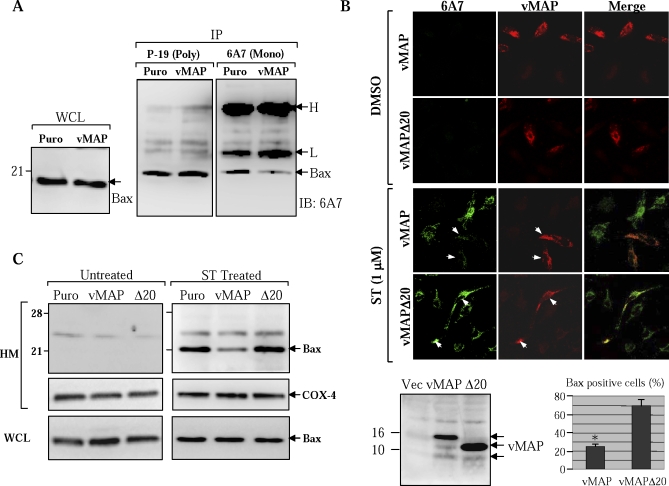
vMAP Inhibits the Mitochondrial Translocation and Activation of Bax(A) vMAP inhibits the apoptotic conformational change of Bax. NIH3T3/puro (Puro) and NIH3T3/vMAP (vMAP) cells were treated with ST (1 μM) for 4 h, harvested, and lysed in 1% CHAPS buffer. Pre-cleared cell lysates were split into two fractions, and each was used for immunoprecipitation with the mouse 6A7 monoclonal antibody or the rabbit P-19 polyclonal antibody, followed by immunoblotting with 6A7. WCLs were analyzed by immunoblotting with 6A7 antibody. Of note, 6A7 antibody reacts only with the activated Bax in immunoprecipitation and immunofluorescence assays, but with pan-bax in the immunoblotting assay. H and L indicate the heavy and light chains of immunoglobulin, respectively. WCL, whole cell lysate.(B) vMAP inhibits Bax activation by immunofluorescence assay. At 16 h post-transfection with a plasmid expressing vMAP or vMAPΔ20, HeLa cells were treated with DMSO or ST (1 μM) for 4 h, fixed, and stained with rabbit anti-vMAP serum (red) and the mouse 6A7 monoclonal anti-Bax antibody (green). A single representative optical section is presented. Arrows indicate cells expressing vMAP or vMAPΔ20. The bottom right graph represents data collected from over 200 transfected cells. Error bars indicate standard deviation with (*) p = 0.01 relative to vMAPΔ20 as calculated by Student's t-test. The bottom left panel shows the expression of vMAP and vMAPΔ20 (Δ20).(C) vMAP inhibits Bax translocation by fractionation. NIH3T3/puro cells (Puro), NIH3T3/vMAP cells (vMAP), or NIH3T3/vMAPΔ20 cells (Δ20) were untreated or treated with ST (1 μM) for 4 h, and the mitochondrion-enriched HM fractions (20 μg) were resolved by SDS-PAGE and analyzed by immunoblotting with antibodies to detect endogenous Bax and COX4. WCLs were analyzed by immunoblotting with anti-Bax antibody (bottom panel).